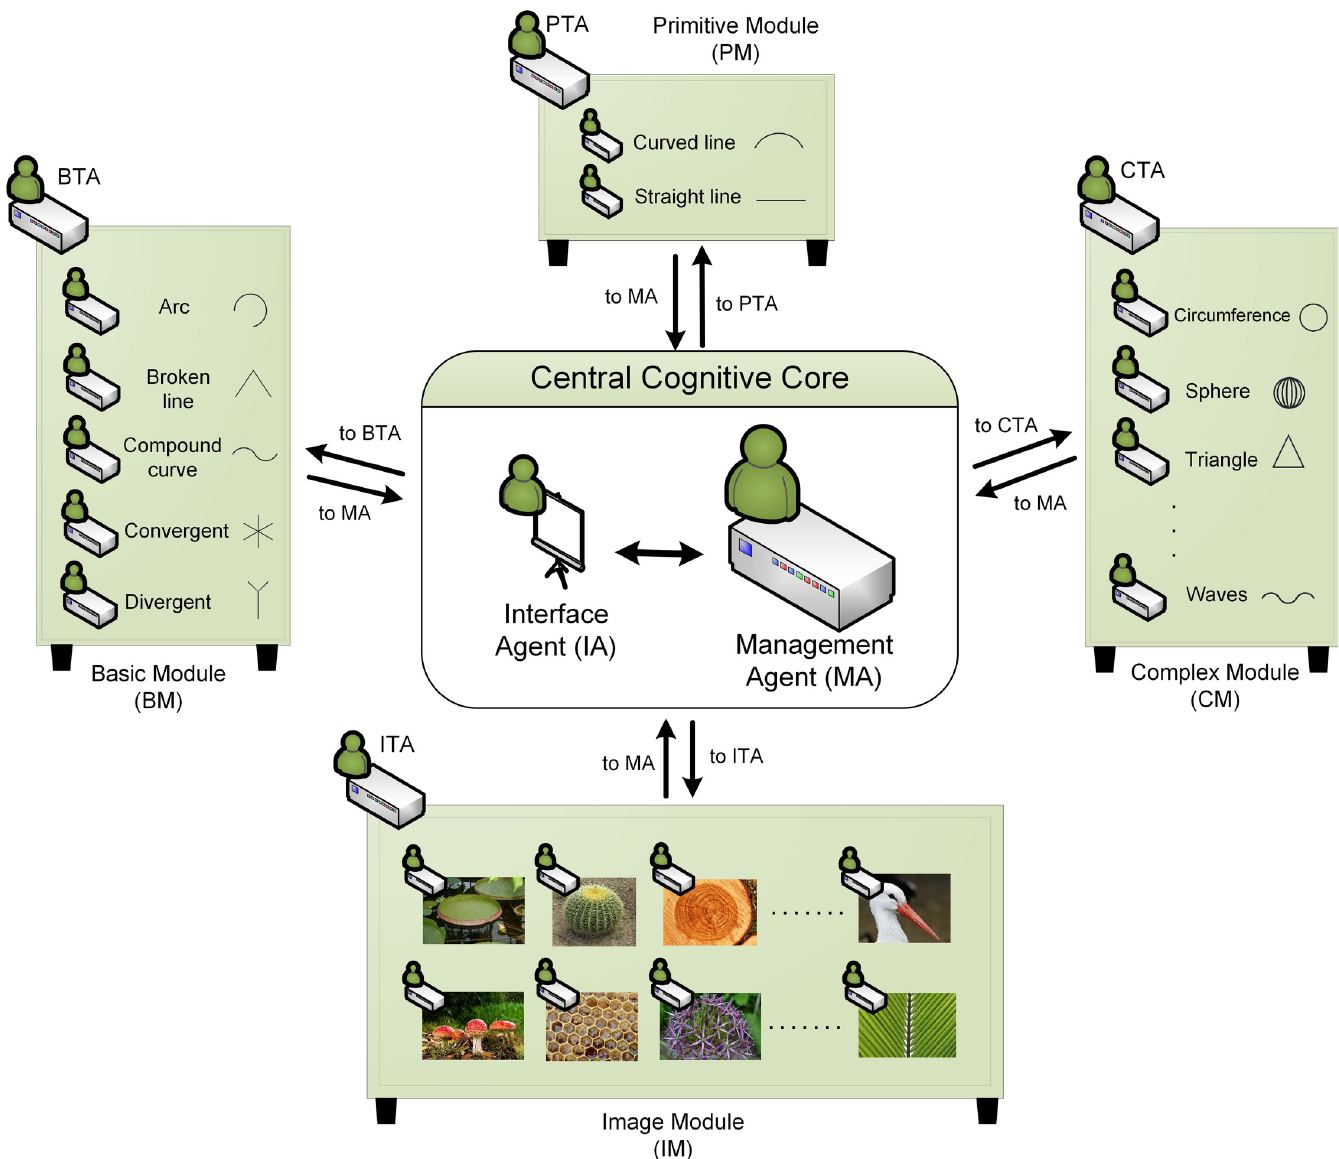
Fig 4. Agent-based architecture of the proposed